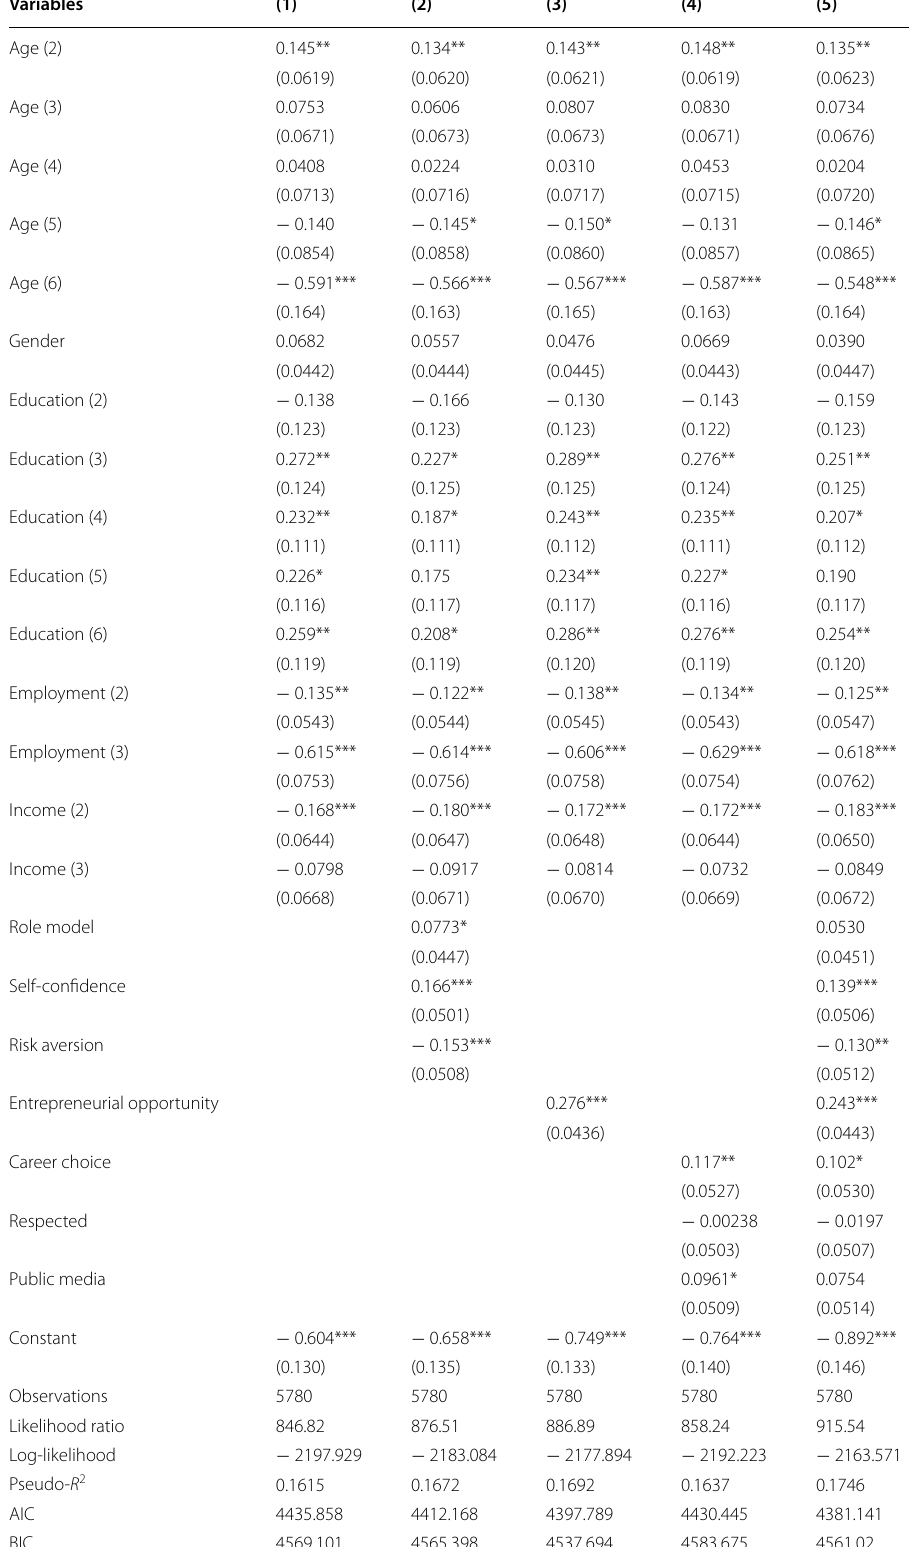
Table 6 Probit regression